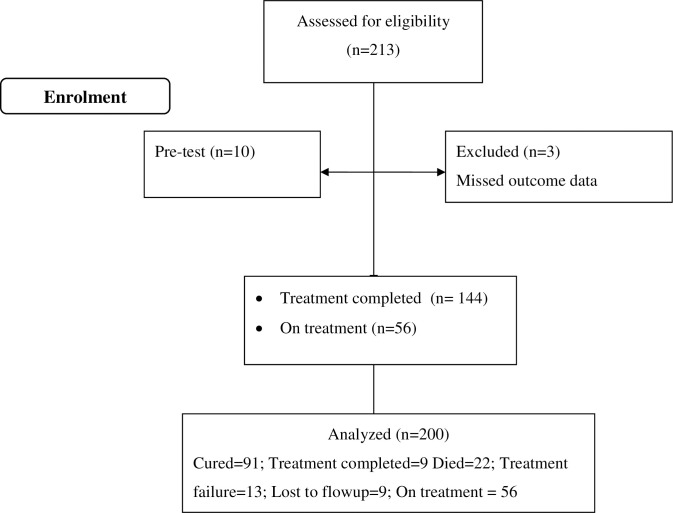
Sample recruitment chart of patients who received MDR-TB treatment at MDR-TB treatment centers located at South and Southwest Ethiopia, April 14 to May 14, 2019.